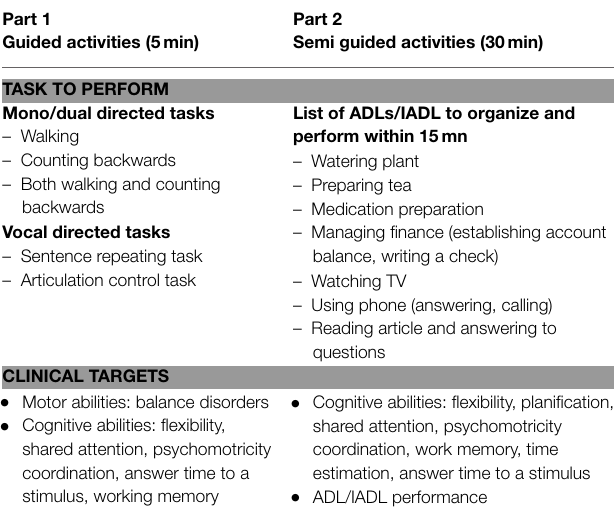
TABLE 1 | Design of ecological assessment